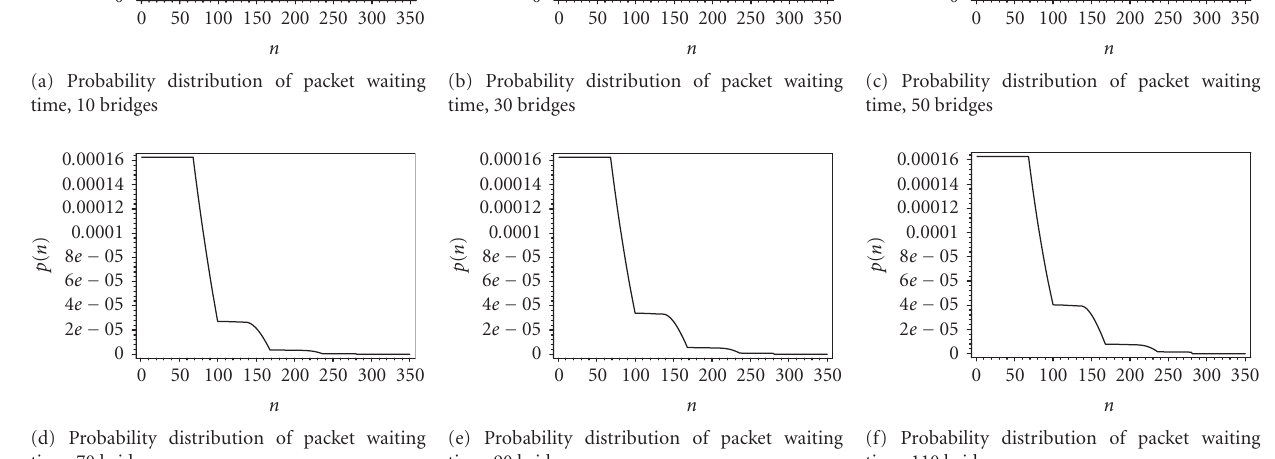
transmission without the backo ff count St = 69 slots. The width of the first peak corresponds to the size of initial backo ff window enlarged by freezing. After first backo ff , transmission is either successful or collided where collision lasts for Ct = 29 slots (which corresponds to the distance between the peaks). As the number of bridges increases,